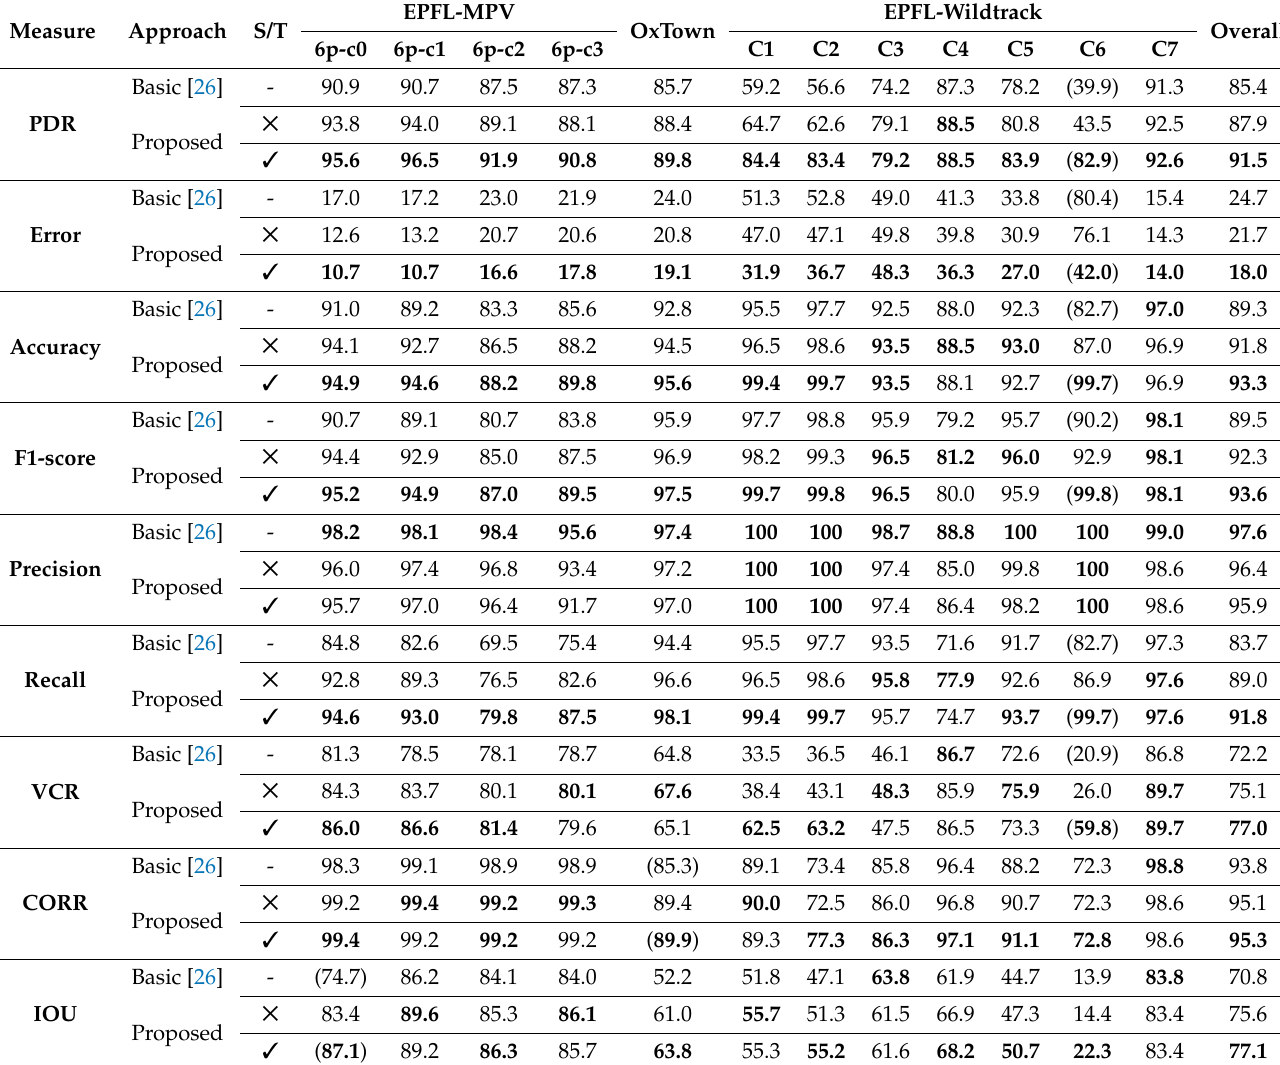
Table 2. The performance evaluation results in terms of PDR, localization relative error, accuracy, F1-score, precision, recall, VCR, CORR, and IOU averaged across the range of safety distances and summarized for each video sequence. The proposed approach is evaluated with ( (cid:51) ) and without ( (cid:53) ) the smoothing/tracking stage (S/T). Best results are in bold to ease interpretation and results depicting highest gain are in brackets for